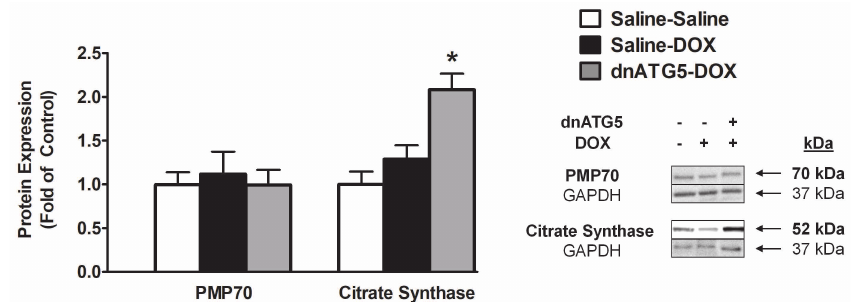
Figure 5. Protein expression of peroxisome membrane protein 70 (PMP70) and citrate synthase. Representative Western blot images are shown to the right of the graph. Values are represented as means ± SEM. * significantly di ff erent versus all groups ( p < 0.05).